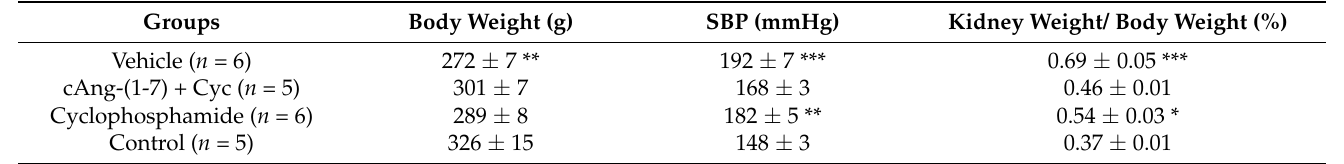
Table 1. Systemic Parameters in Rats with